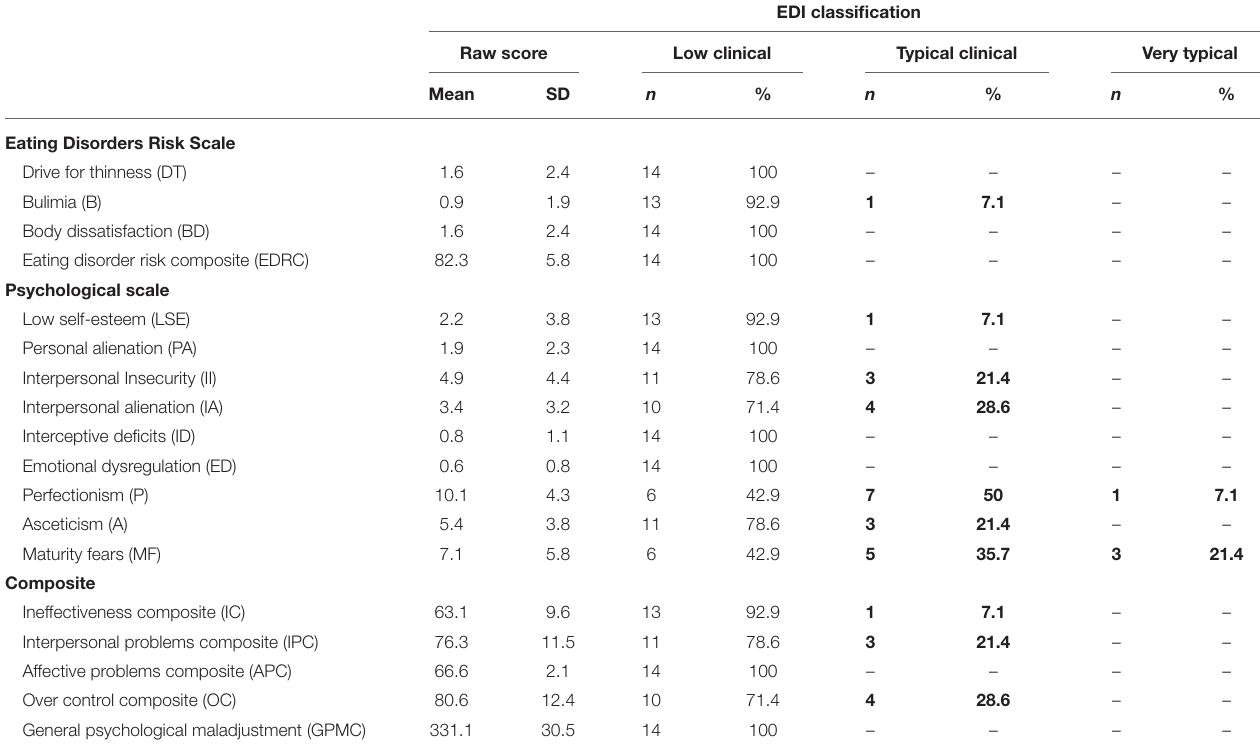
TABLE 3 | Eating disorder characteristics among endurance trained male athletes ( n = 14).